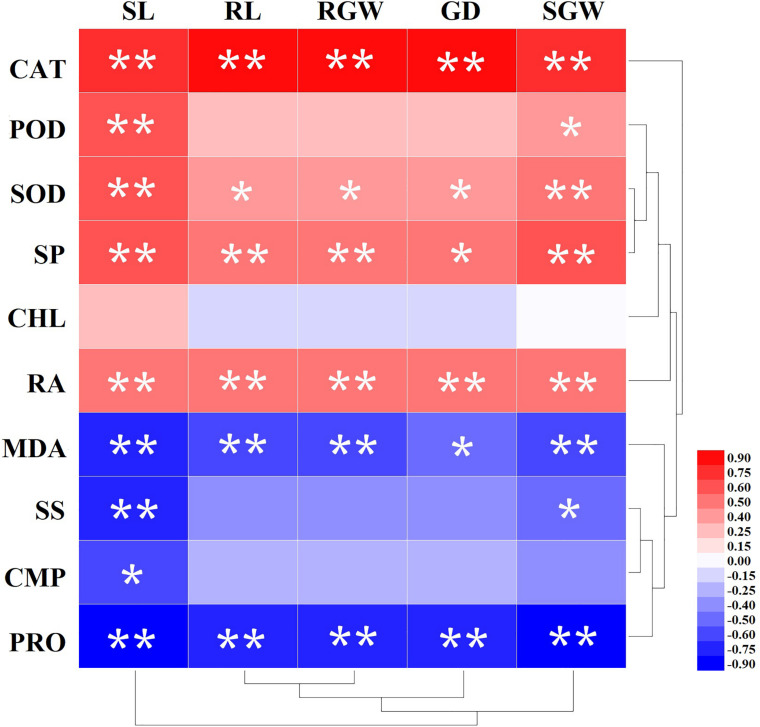
Correlation analysis of Amygdalus pedunculata growth and physiological and biochemical indexes. Two stars indicate that indexes showed a highly significant correlation (P < 0.01), and one star indicates that indexes showed a significant correlation (P < 0.05). The brightness of the red or blue color represents the value of the correlation coefficient.